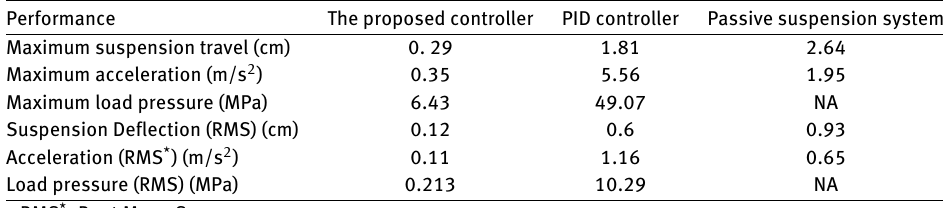
Table 9. Performance comparison while the system with varied parameters is imposed by random road profile depicted in Figure